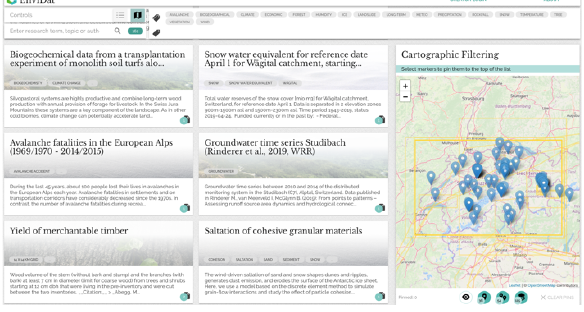
Figure 1. Environmental data sets in EnviDat